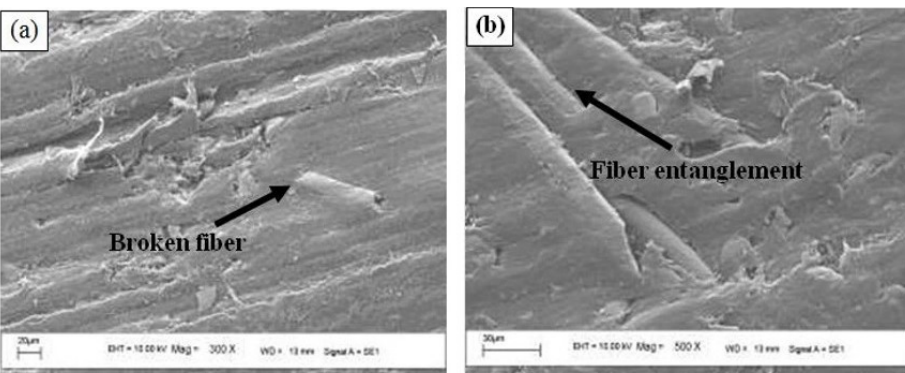
Figure 12. (a-b) Morphological Structure of long fiber reinforced epoxy at 29.43